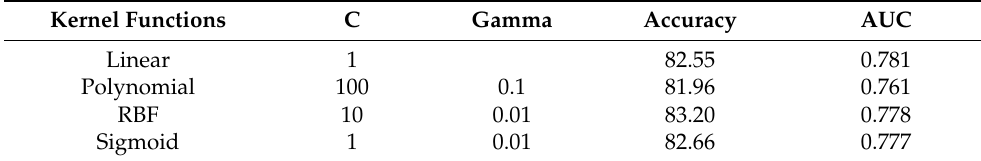
Table 5. Accuracy and AUC of best performance for four kernel functions on test data set.